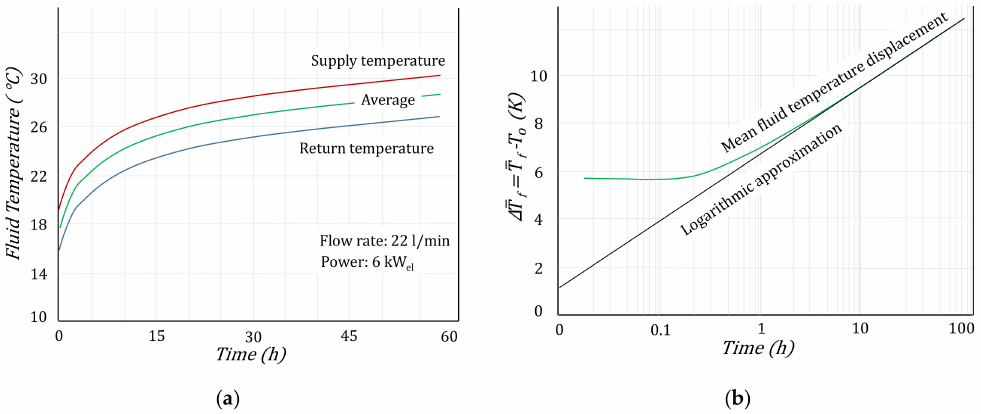
Figure 4. Typical evolution of fluid temperatures in a TRT plotted on a ( a ) linear and ( b ) semi-log